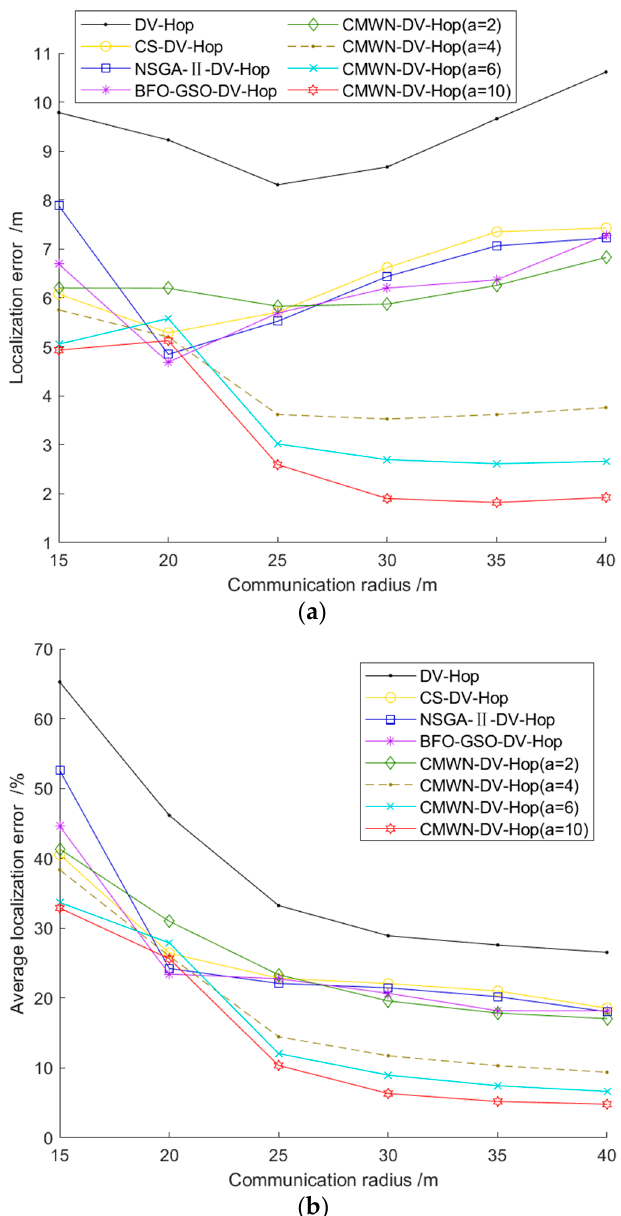
Figure 11. Comparison of various localization algorithms with communication radius: ( a ) localization error and ( b ) average localization error.